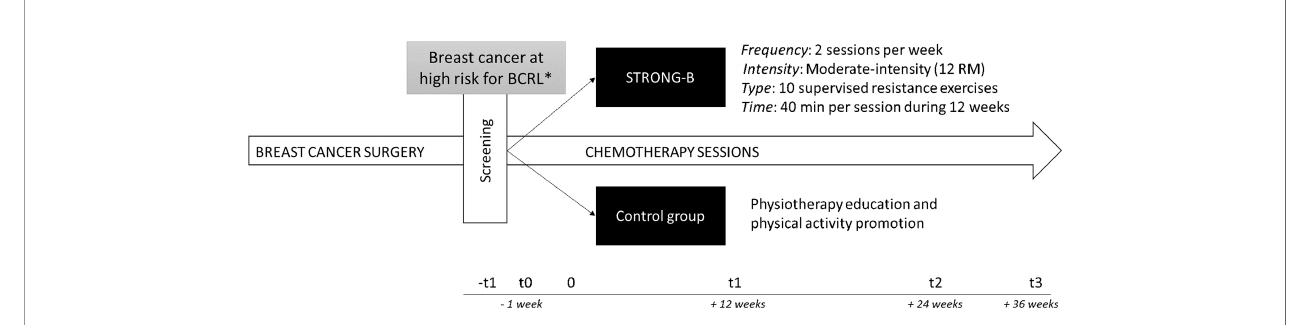
FIGURE 3 | Study design. *Breast cancer at high risk for breast cancer-related lymphedema (BCRL) has been established as having had: [a] total or partial mastectomy with axillary node dissection; [2] sentinel node biopsy with positive axillary web syndrome; or [3] sentinel node biopsy along with a body mass index between 30.0 and 39.9; F, frequency; I, intensity; T, type;